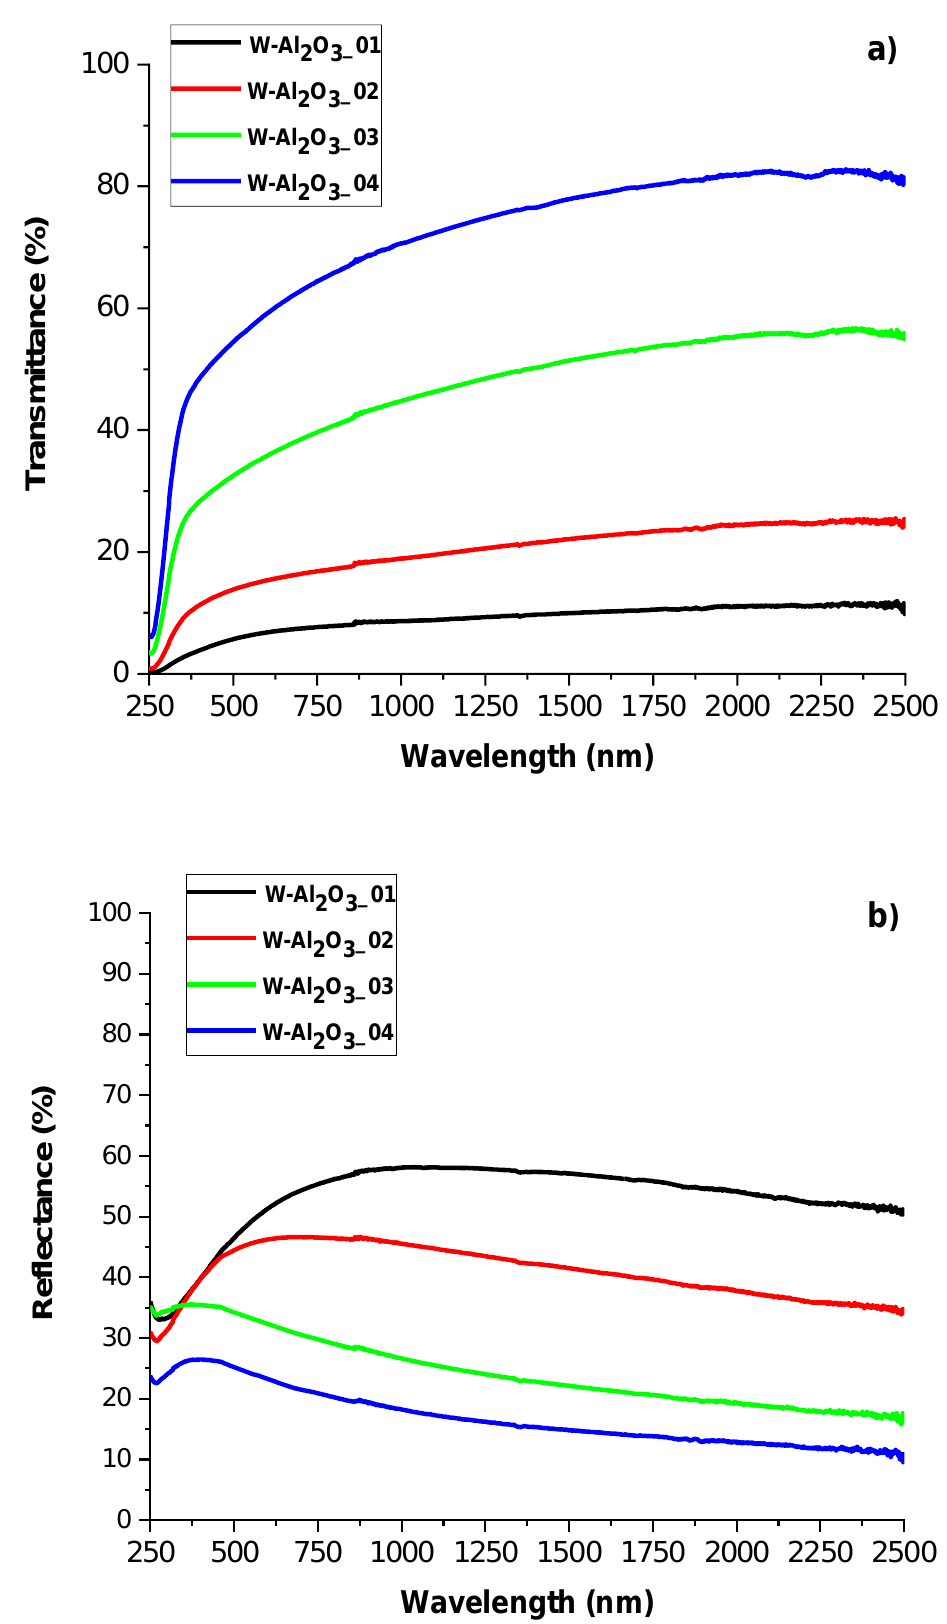
Figure 6. Transmittance ( a ) and reflectance ( b ) curves of cermet samples obtained at different power densities applied to the W target and a fixed power density applied to the Al targets.